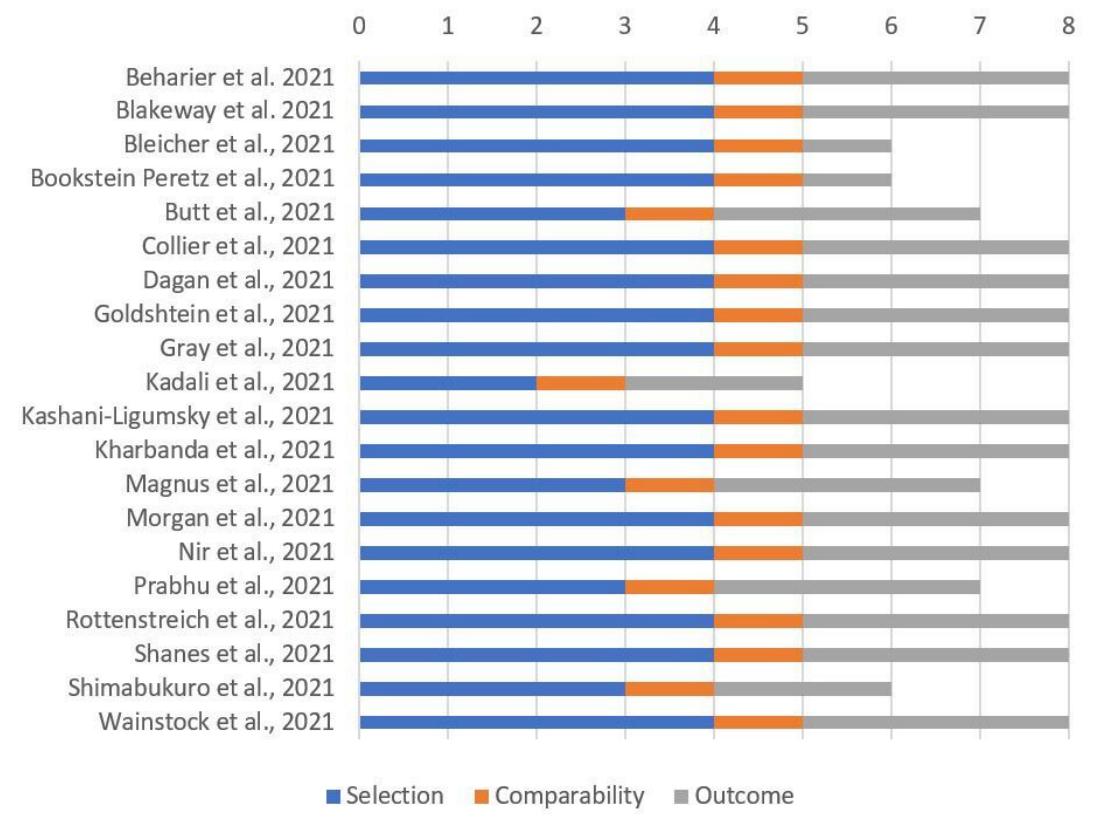
Figure 3. Quality assessment of included cohort studies involving pregnant women through “New- castle–Ottawa Scale for cohort studies”.